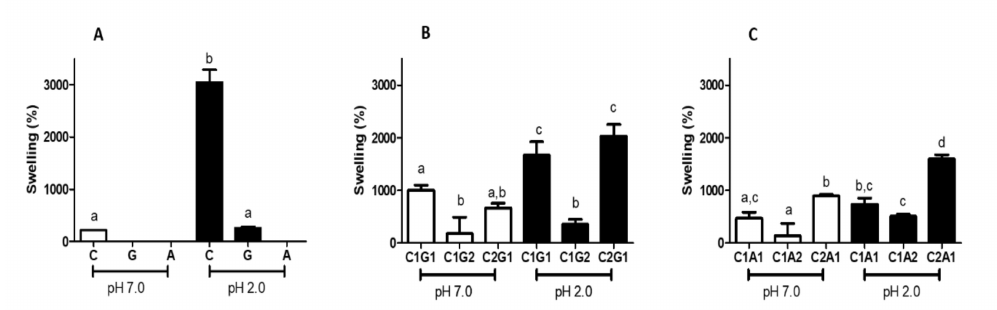
Figure 3. Swelling degree after 24 h of hydrogel polymers ( A ), polyelectrolytes complexes of chitosan and xanthan gum ( B ), and chitosan and alginate ( C ). The environment solution was distilled water (pH 7.0—white bars) and HCl-tris bu ff er (pH 2.0—black bars). C—Chitosan; G—Xanthan gum; A—Alginate;